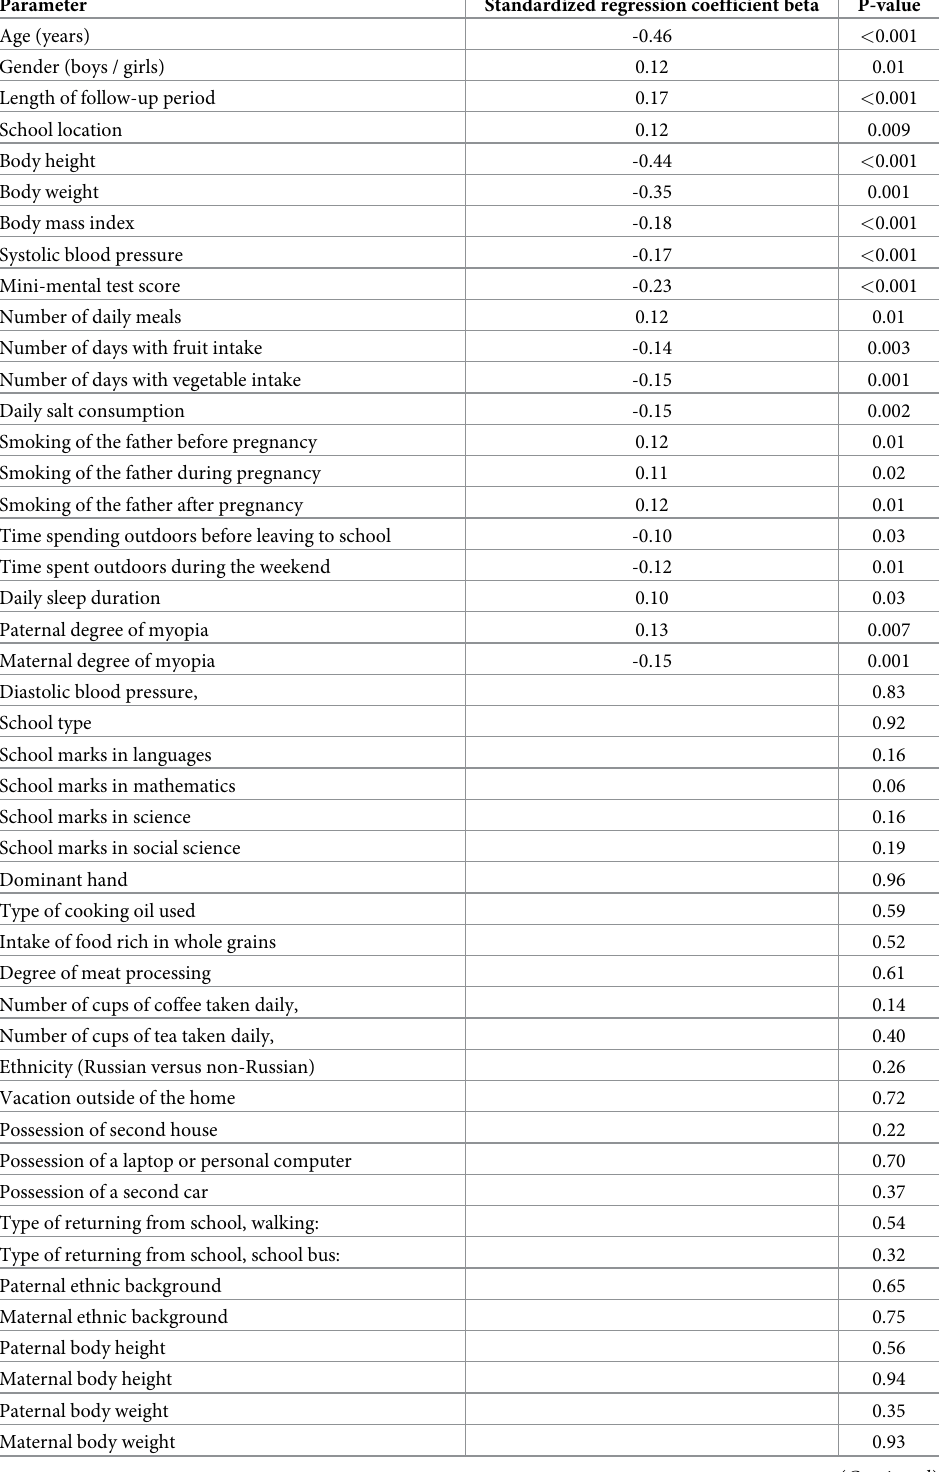
Table 3. Associations (univariable analysis) between the axial elongation during the study period and systemic and ocular